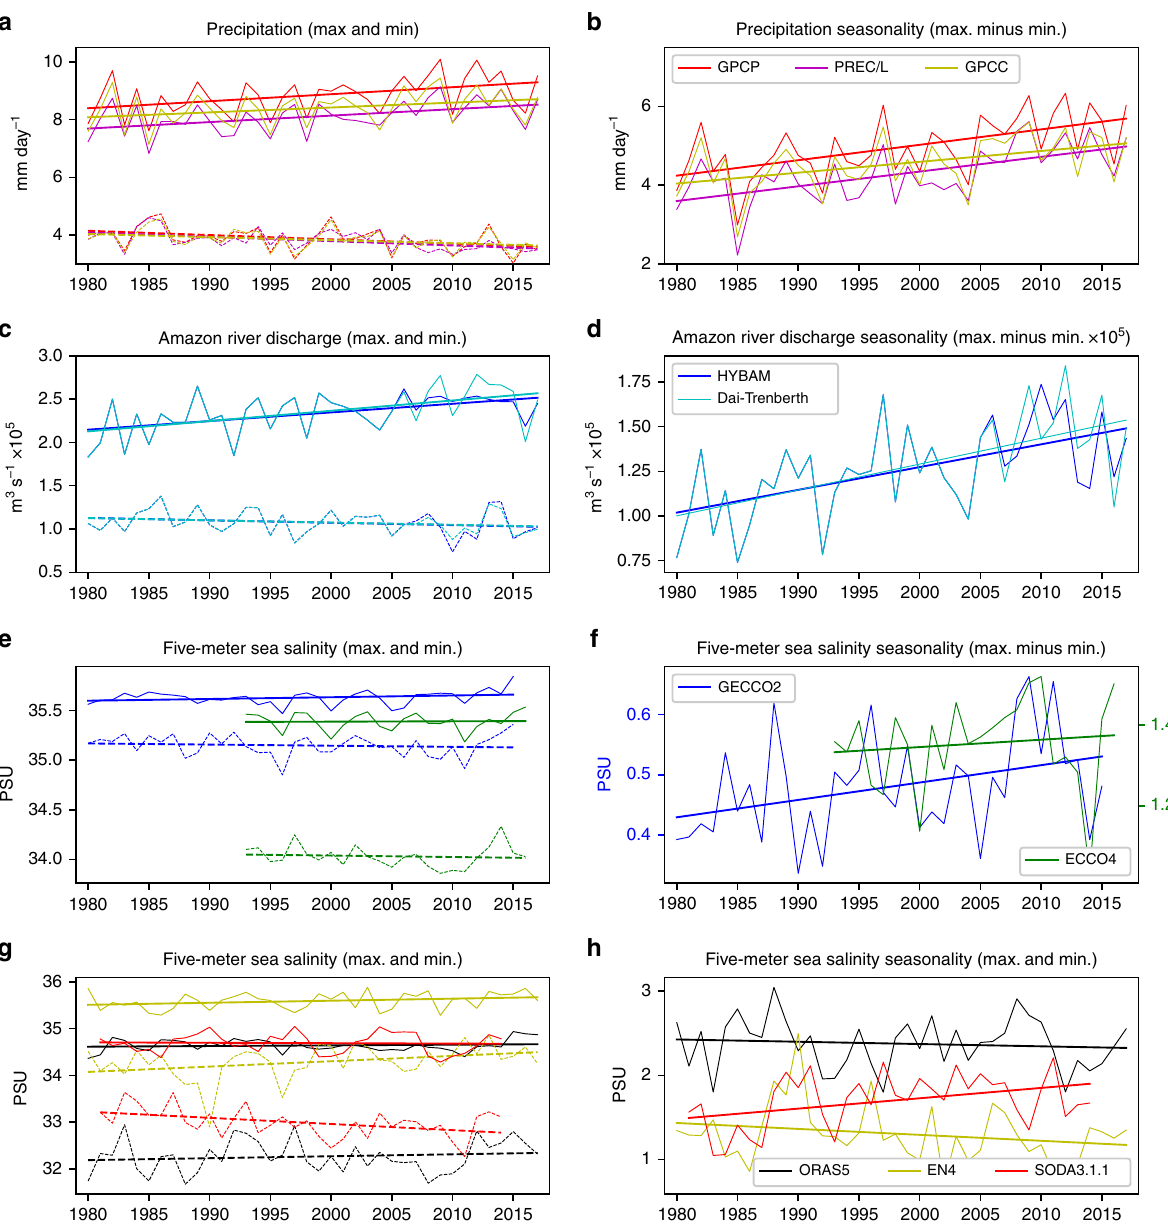
Fig. 2 Evolution of the annual maximum and minimum values and seasonality for Amazonia precipitation, Amazon river discharge, and Amazon plume region (APR) ocean salinity. a Amazonia precipitation during the period 1979 – 2018. b The seasonality of Amazonia precipitation (maximum minus minimum values) during the period 1979 – 2018. c , d , e , f , and g , h are similar to a , b , but for Amazon river discharge and APR ocean salinity, respectively. Note that ECCO4 salinity data only cover the period 1992 – 2017; GECCO2 the period 1979 – 2016; and SODA3.1.3 the period 1980 – 2015. The solid (dashed) lines are the linear fi ts used to determine the